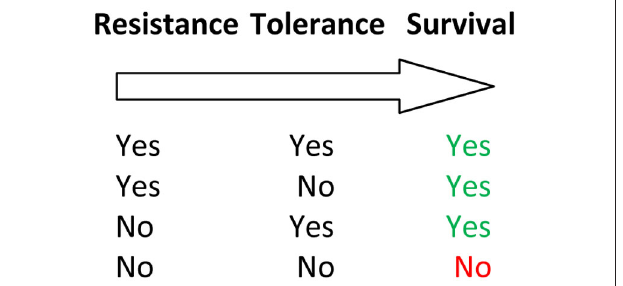
FIGURE 3 | Contribution of resistance and tolerance to mortality due to a specific pathogen. Only individuals without resistance and tolerance will eventually die given a sufficiently long follow-up period. When having a limited follow-up period, individuals with high tolerance may still be alive at the end of an